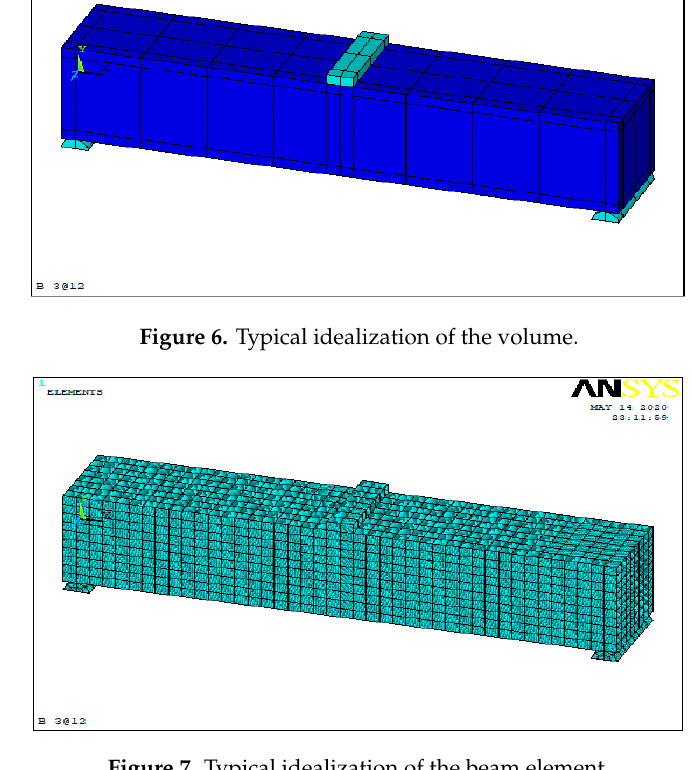
Figure 7. Typical idealization of the beam element.